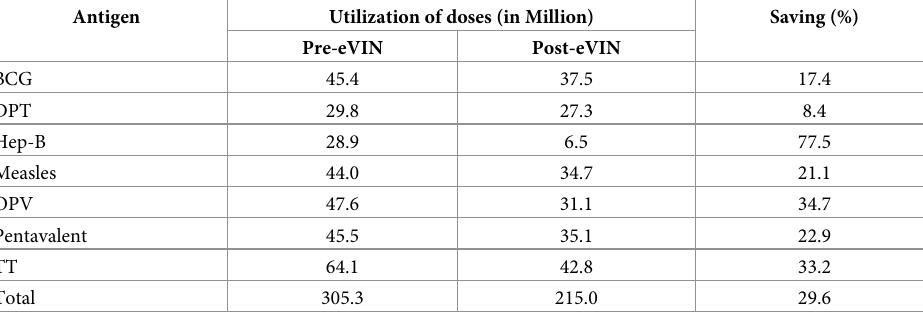
Table 3. Vaccine-wise saving of doses.